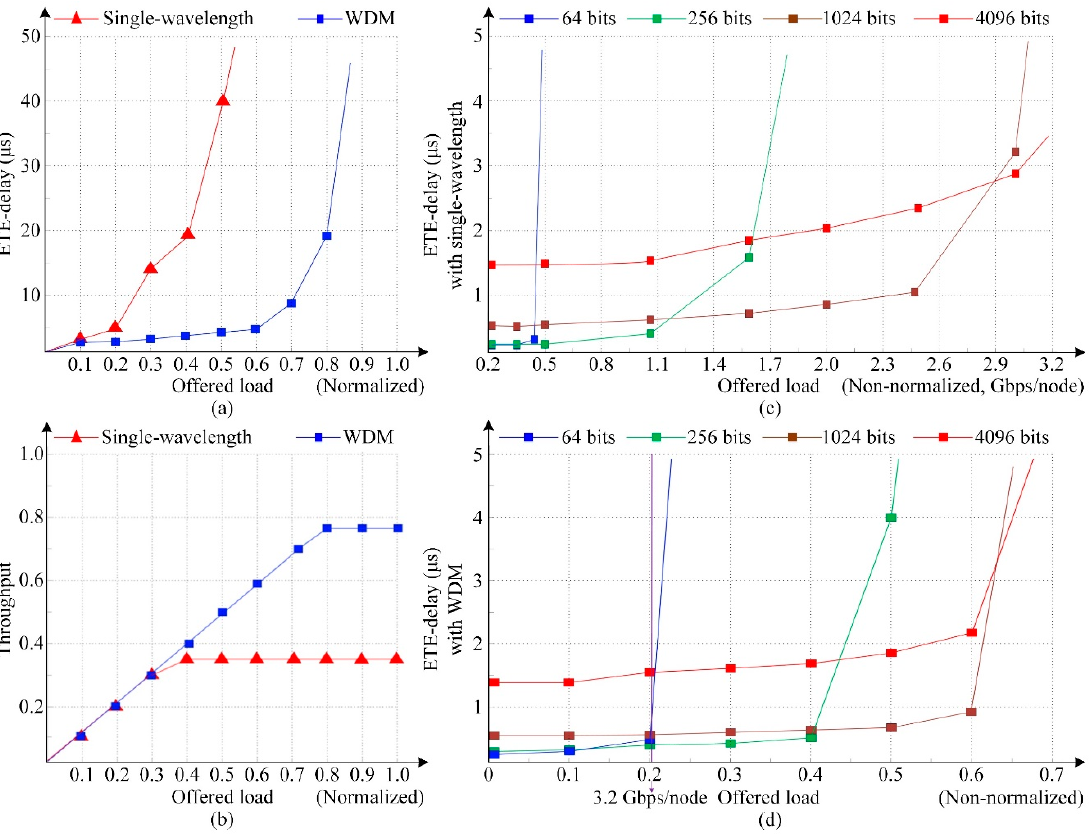
Figure 14. Network ETE delay and throughput comparison of torus-based ONoCs with single wavelength and WDM technology at data rate 12.5 Gbps.